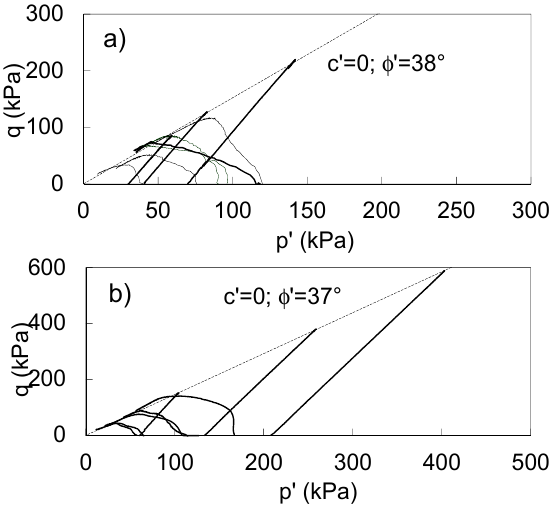
Figure 4. Triaxial test results on natural samples of pyroclastic soils: ( a ) Cervinara; ( b ) Sarno.